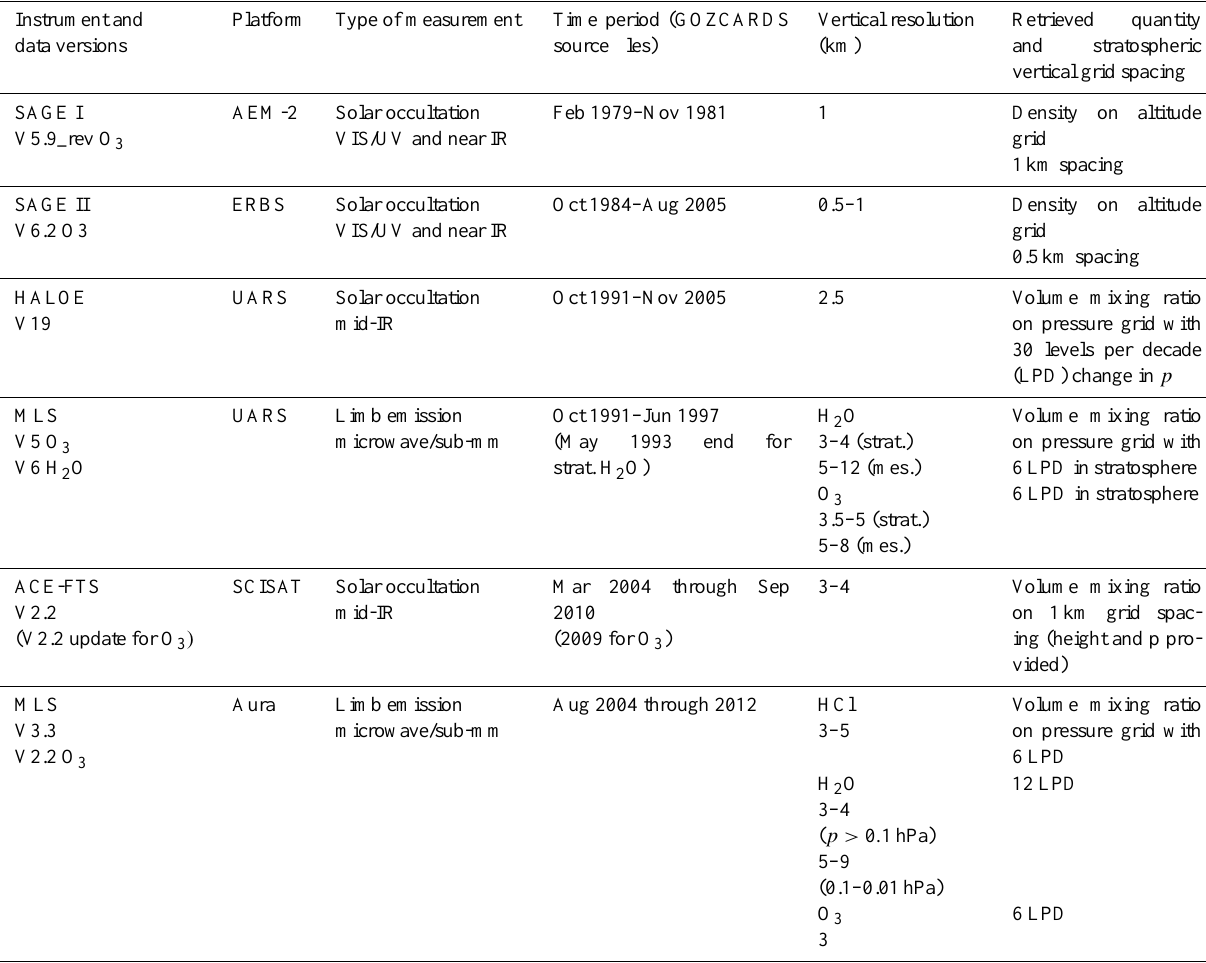
Table 1. Characteristics of instrument data sets used to create GOZCARDS ESDRs (version ev1.01). Instrument